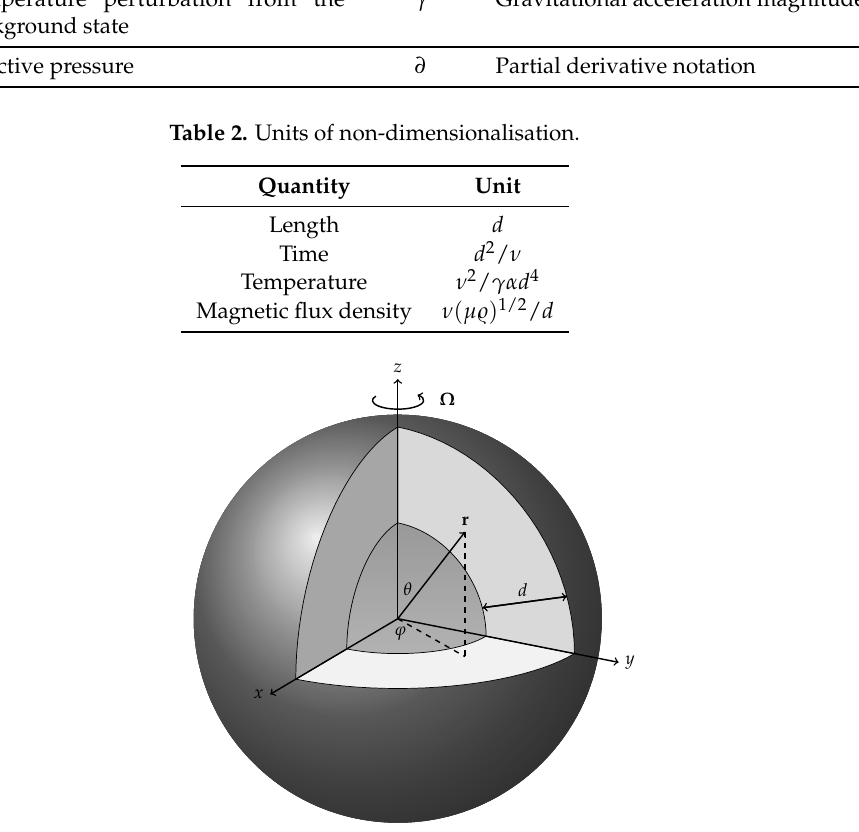
Figure 2. Schematic illustration of the three-dimensional region considered in this study, the associated spherical coordinate system and the position of the axis of rotation. The region is assumed full of electrically conducting